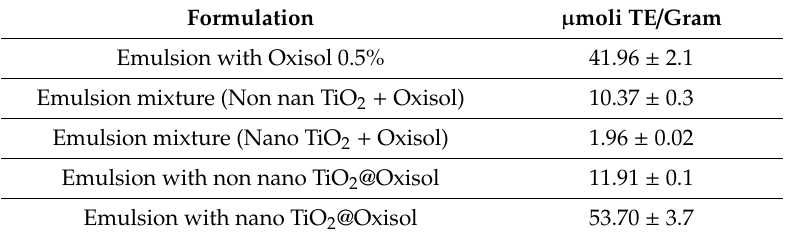
Table 5. PCL results performed on the emulsions containing TiO 2 . Each value was obtained from three di ff erent experiments (mean ±